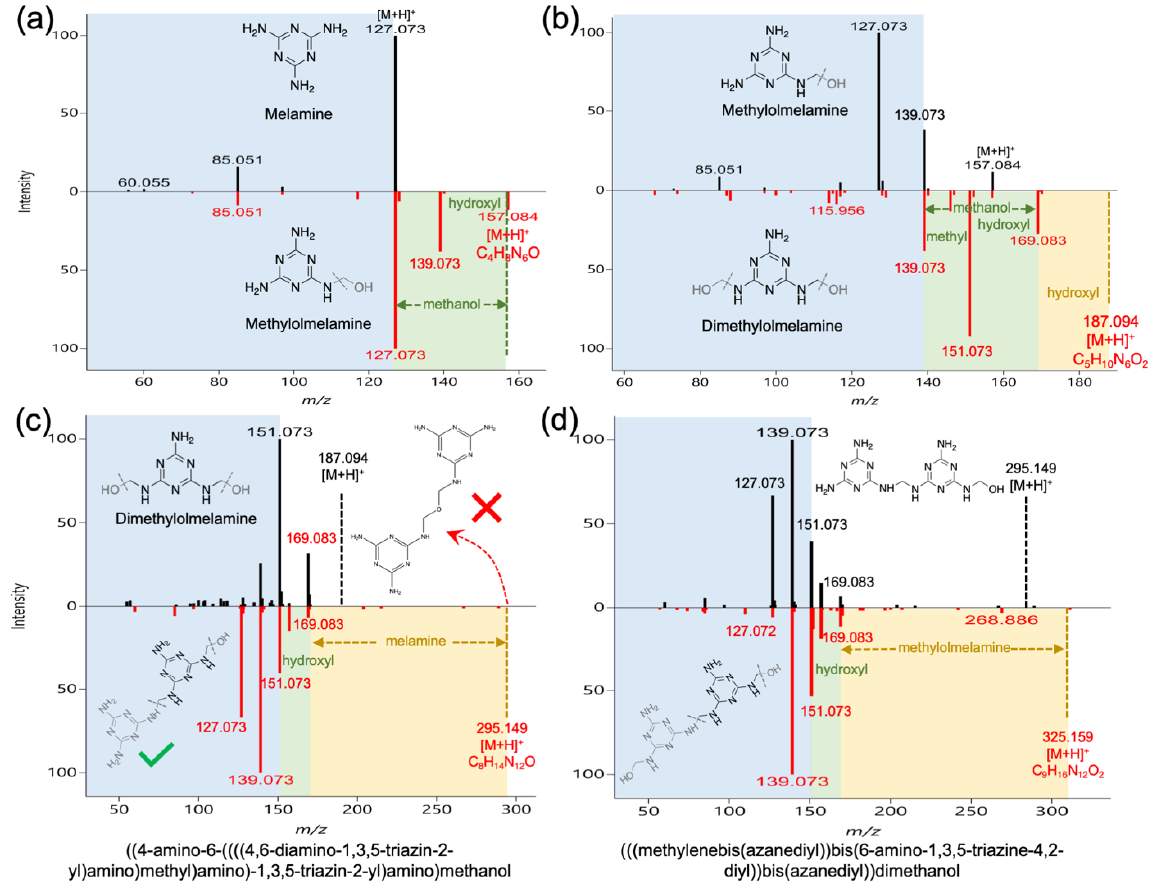
Figure 2. Elucidation of four melamine derivatives based on their similarity in MS/MS spectra. ( a ) Methylolmelamine; ( b ) Dimethylolmelamine; ( c ) ((4-amino-6-((((4,6-diamino-1,3,5-triazin-2- yl)amino)methyl)amino)-1,3,5-triazin-2-yl)amino)methanol; ( d ) (((methylenebis(azanediyl))bis-(6- amino-1,3,5-triazine-4,2-diyl))bis(azanediyl))dimethanol With respect to the peak 295.149 m/z with a formular C 8 H 14 N 12 O (Figure 2c), it could